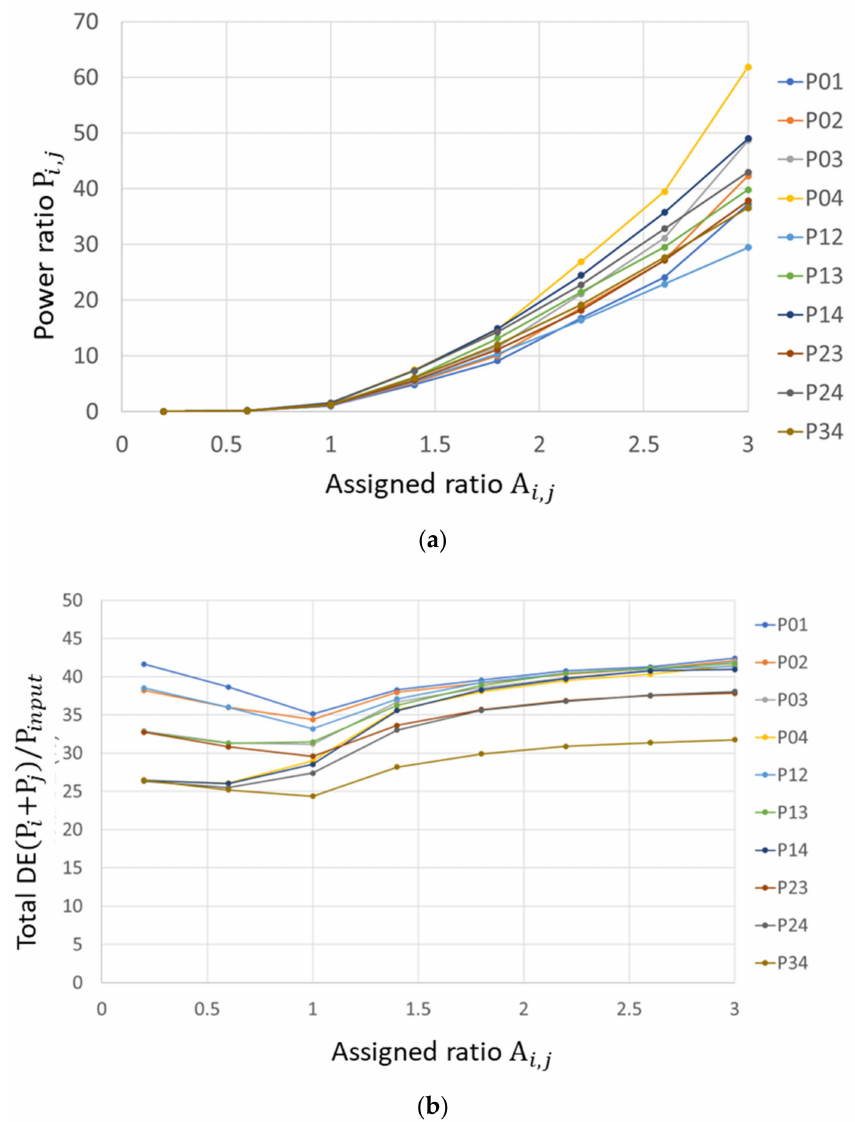
Figure 9. ( a ) P i , j as a function A i , j for all the combinations of ( i , j ), 0 ≤ i , j ≤ 4; ( b ) the total diffraction efficiency DE total , i , j = ( P i + P j ) /P input , where P i and P input are the diffracted power to i-th ROI and total power impinging upon the PLM,